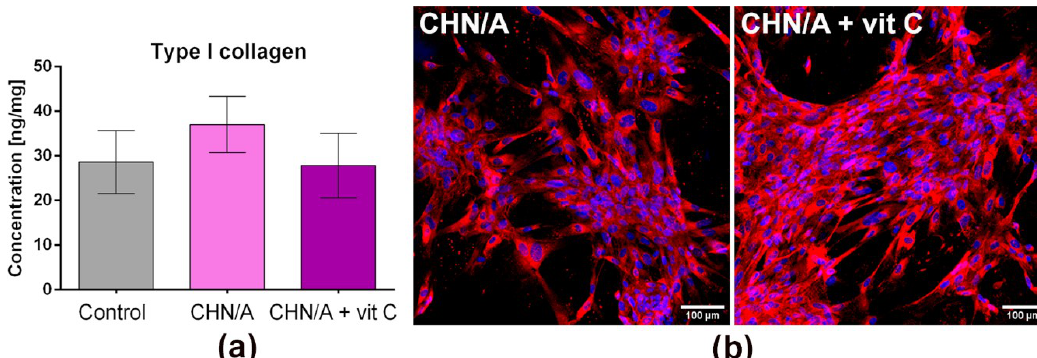
Figure 7. Results obtained with ELISA and immunofluorescence to detect the production of type I collagen by BJ fibroblasts grown on the surface of the films: ( a ) the level of type I collagen in the lysates of fibroblasts cultured for 6 days on the surface of the films assessed by ELISA; collagen synthesis was normalized per 1 mg of cellular proteins (control—cells cultured on the glass coverslip; n = 3 (three independent samples were tested)); ( b ) type I collagen deposited in the 6-day fibroblast culture performed on the surface of the films visualized by immunofluorescent staining (nuclei—blue fluorescence, type I collagen—red fluorescence).